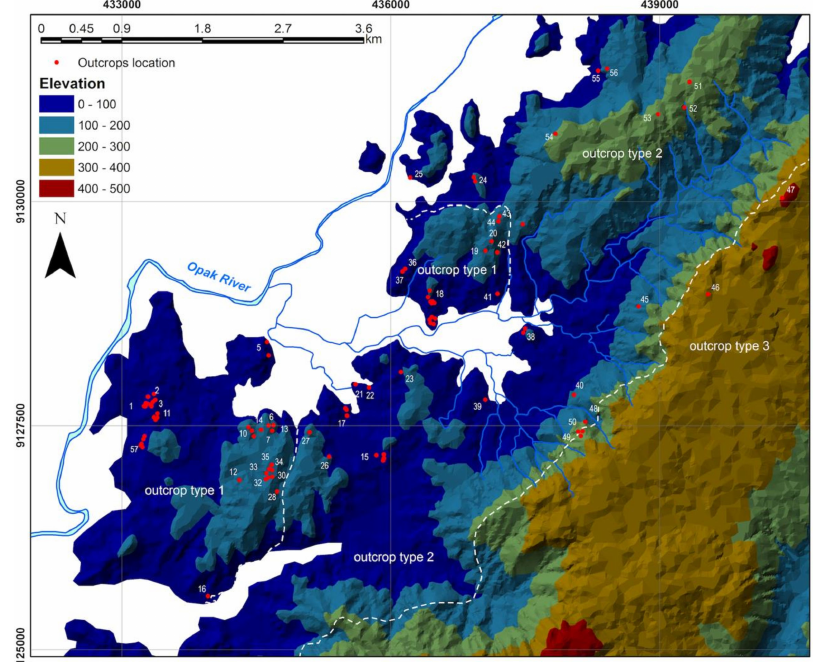
Figure 16. Outcrops